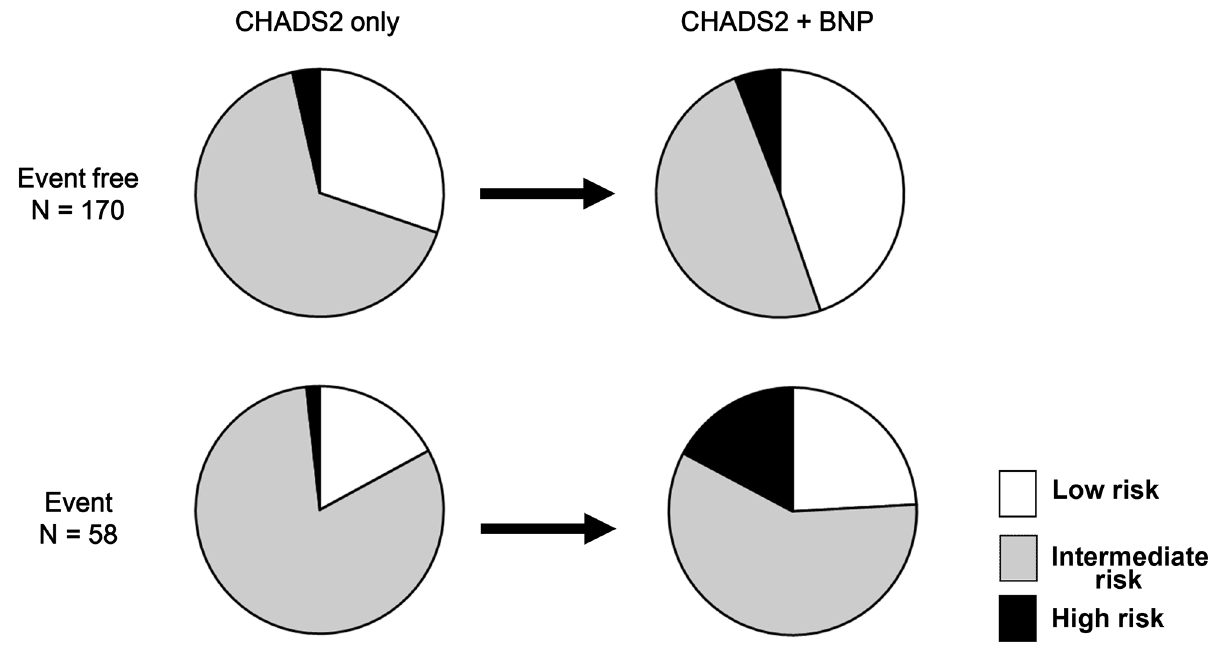
Figure 4. Changes in risk stratification capacity derived from reclassification tables in terms of CHADS2 score only model and CHADS2 plus BNP model. To compare with CHADS2 only model, the combination model increased the percentage of low risk group in the non events group (from 30% to 45%), and the percentage of high risk group in the events group (from 2% to 17%). doi: